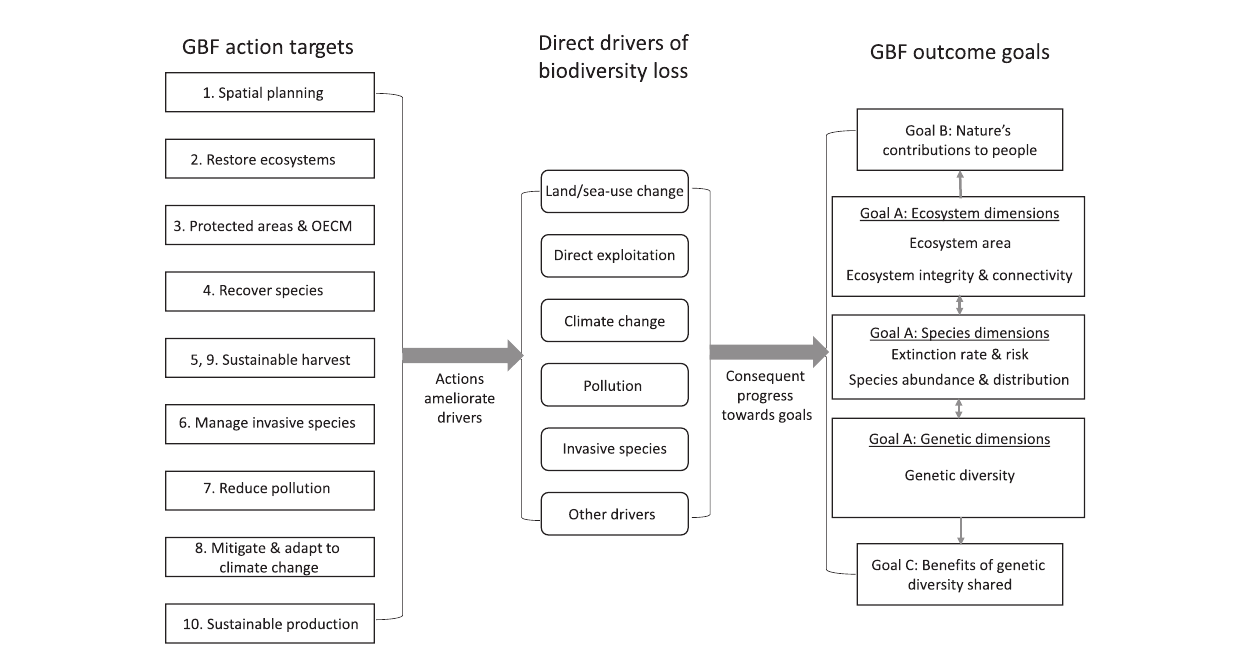
FIGURE 1 | Diagram of relationships between Global Biodiversity Framework (GBF) targets and goals and direct drivers of biodiversity loss. Conservation actions to achieve GBF targets help ameliorate drivers of biodiversity loss and achieve progress towards the GBF ’ s goals (i.e., desired outcomes). The GBF also includes additional targets not shown here designed to address both indirect drivers of biodiversity loss and additional GBF goals which are not directly focused on biodiversity loss. For a detailed discussion and depiction of relationships between GBF targets, drivers, and goals, see Leadley, et al. (2022), and for a detailed description of drivers of biodiversity loss, see IPBES